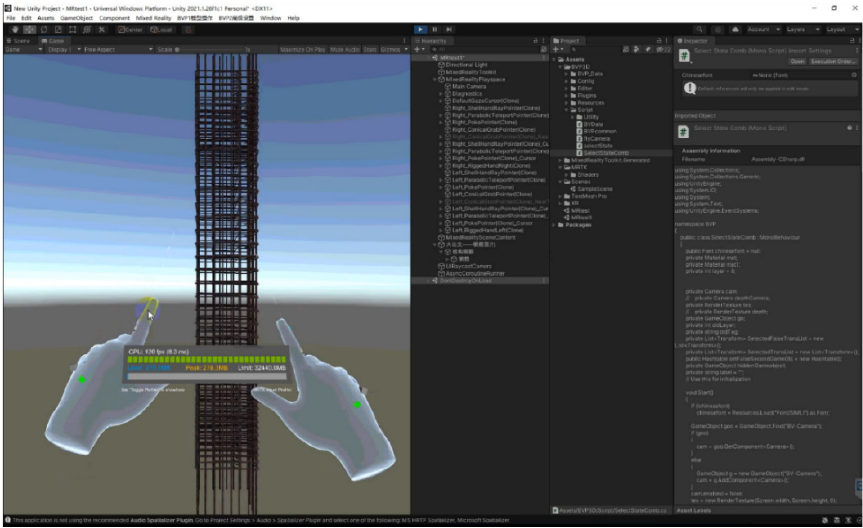
Figure 13. Interaction with the Revit model in mixed reality.